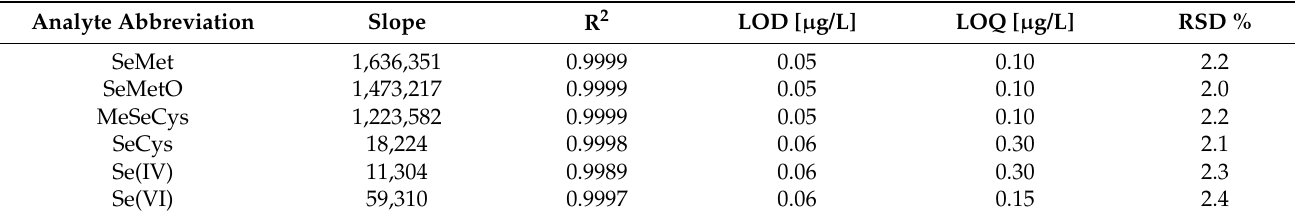
Figure 5. The influence of the DTT (5mM) and β ME (0.005%) addition on the slope of the calibration curves for SeMet and SeMetO. ZIC HILIC column, mobile phase: MeOH/ water (85/15, v / v ). Table 2. Parameters of the calibration equations and validation parameters in ZIC-HILIC separation using methanol/water eluent (85/15, v / v ). Analyte Abbreviation Slope SeMet SeMetO 1,473,217